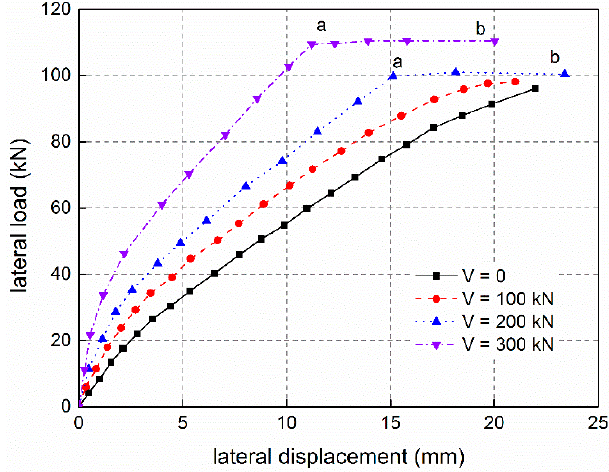
Figure 6. Lateral load vs displacement from combined loading tests (modified from Karasev et al.